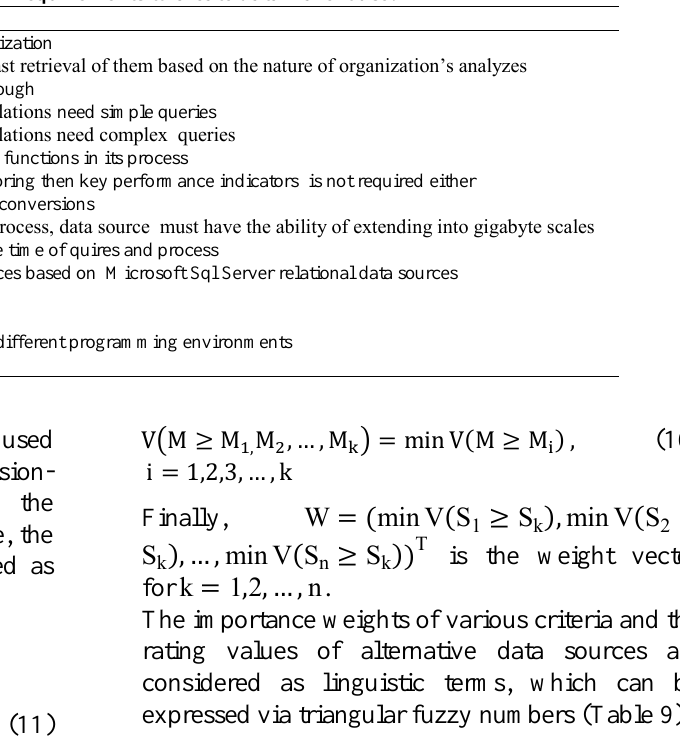
Table 8. Organization requirements to create data warehouse.